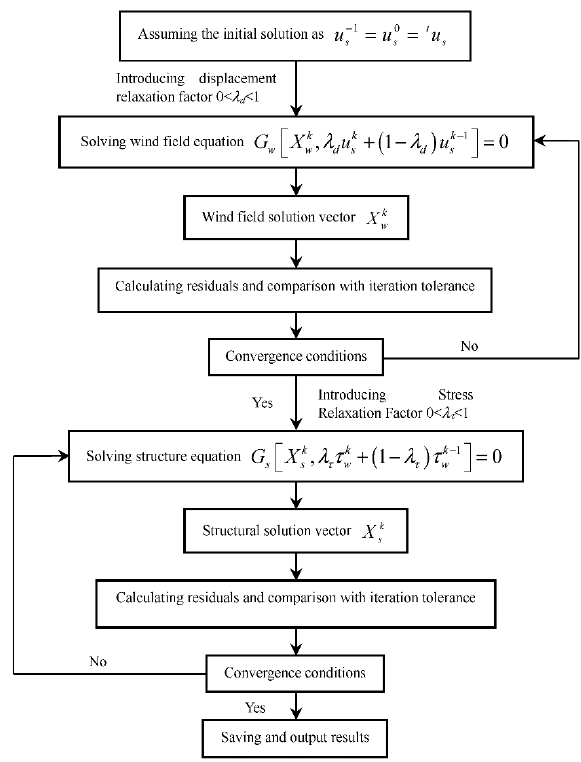
Figure 2. Shell–wind interaction solution.